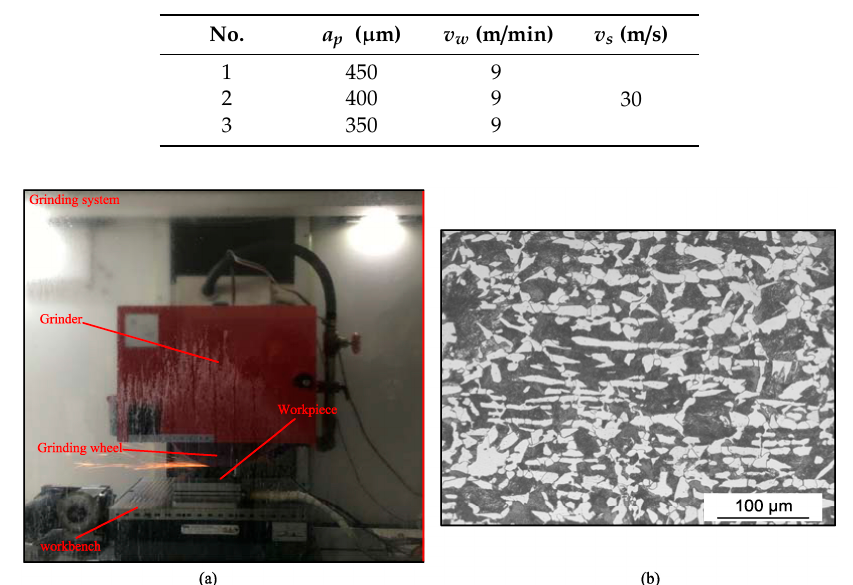
Table 7. Experimental grinding parameters.